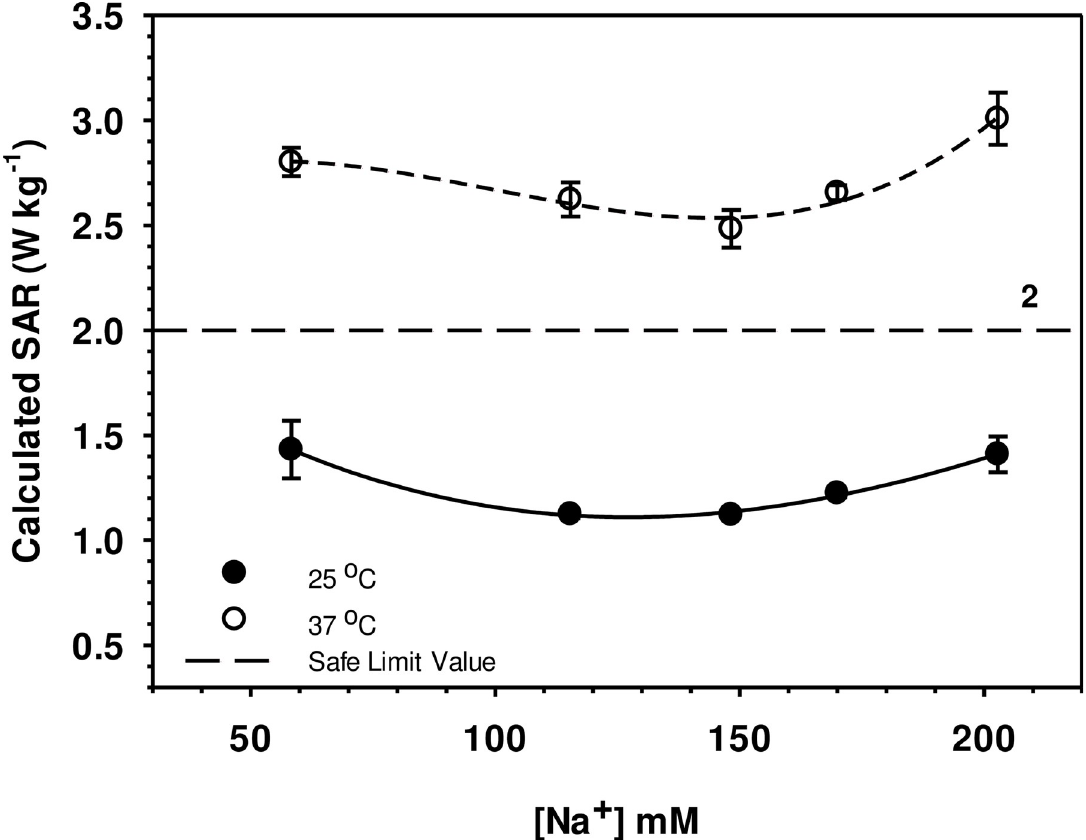
Fig 6. Calculated SAR of cytoplasm of HRBC over [Na + ] at standard laboratory benchmark temperature and normal body temperature. The prescribed upper legally safe limit guideline is 2.0 W kg -1 for 10 g body tissue for 900 MHz EM (dotted line). Error bars are ± SE, means based on 5 replicates (5 separate individuals): the fitted lines are spline curves [35]. The Tukey test interval for testing for significant (p < 0.05) differences between any two mean values was SAR = 0.399: SAR at each [Na + ] were all different at 25 vs . 37˚C but SAR at 25˚C and 37˚C were generally not significantly different with the exception of SAR at 37˚C and at control (148 mM) Na + and at 202 mM Na +